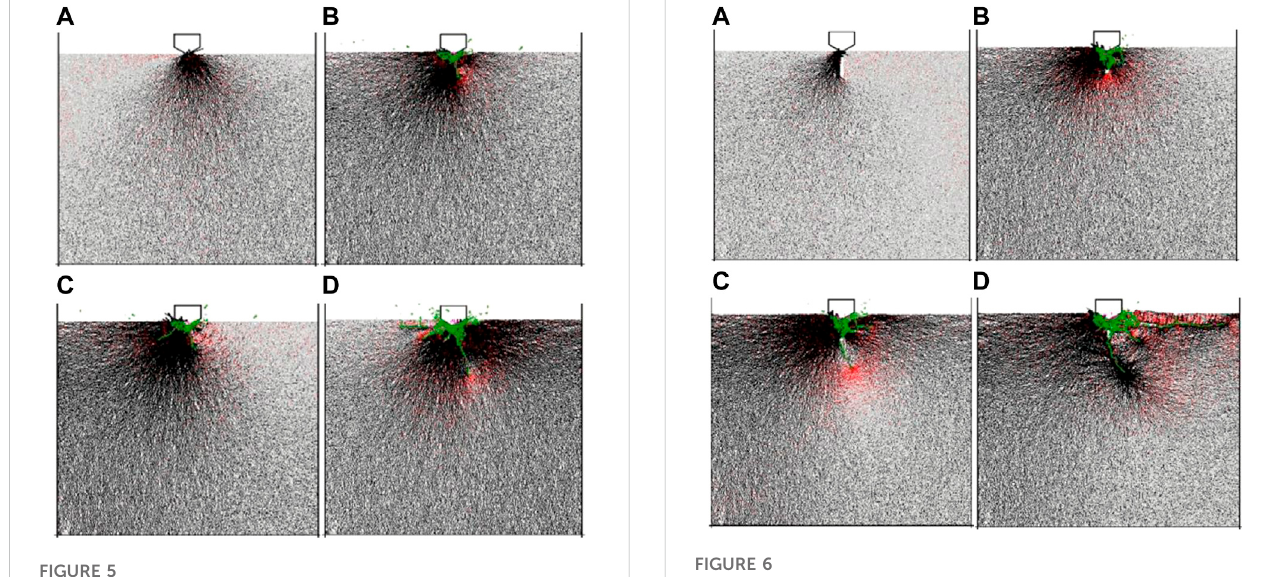
FIGURE 5 Simulation of the failure evolution of the complete cutting model